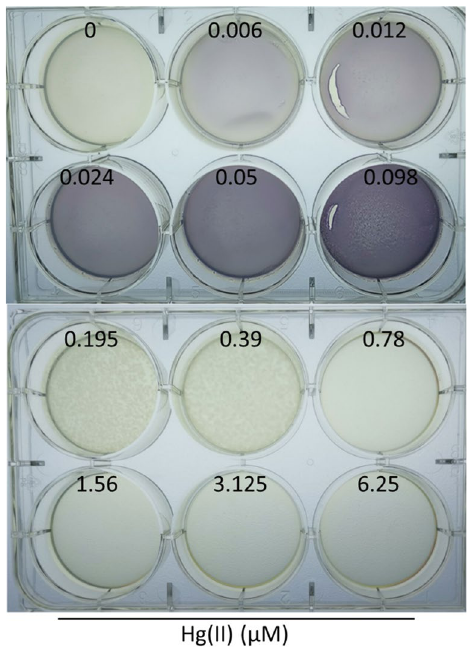
Figure 7. The detection sensitivity of TOP10/pPmer-vio toward Hg(II) on the LB-agar plate. Exponential- phase culture of TOP10/pPmer-vio was spread on LB-agar plates with increasing concentrations of Hg(II), and cultured at 37 °C overnight. A representative image of three independent experiments with similar results is shown.